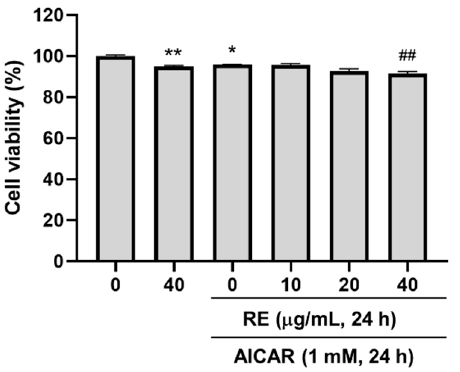
Figure 4. Effects of rosemary extract (RE) on the viability of 5-aminoimidazole-4-carboxamide ribonucleoside (AICAR)-treated C2C12 myoblasts: C2C12 myoblasts were treated with AICAR (1 mM) and indicated concentrations of RE, cultured for 24 h, and then evaluated using the MTT assay. Values and error bars indicate means ± SD of three separate experiments. *, significant difference between RE- and vehicle-treated cells before differentiation (ANOVA, p < 0.05); **, significant difference between RE- and vehicle-treated cells before differentiation (ANOVA, p < 0.01); ##, significant difference between RE- and AICAR-treated cells before differentiation (ANOVA, p < 0.01).